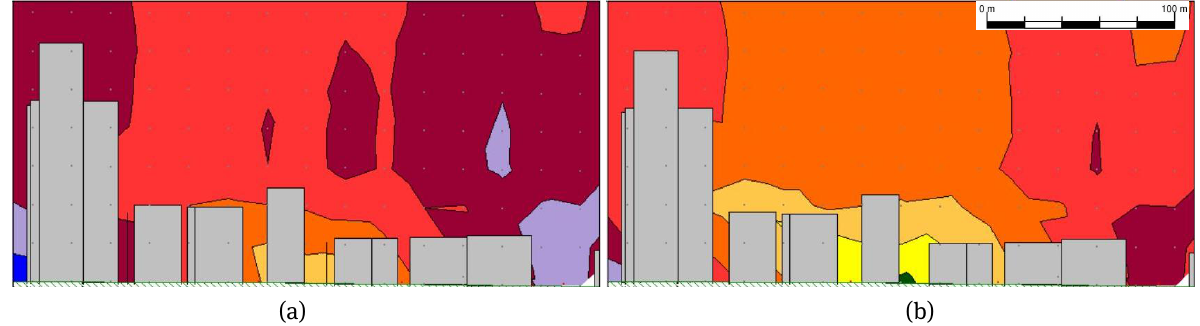
Figure 11: Cross section B, as indicated on Figure 8: (a) Pre-pandemic scenario and (b) pandemic one on the